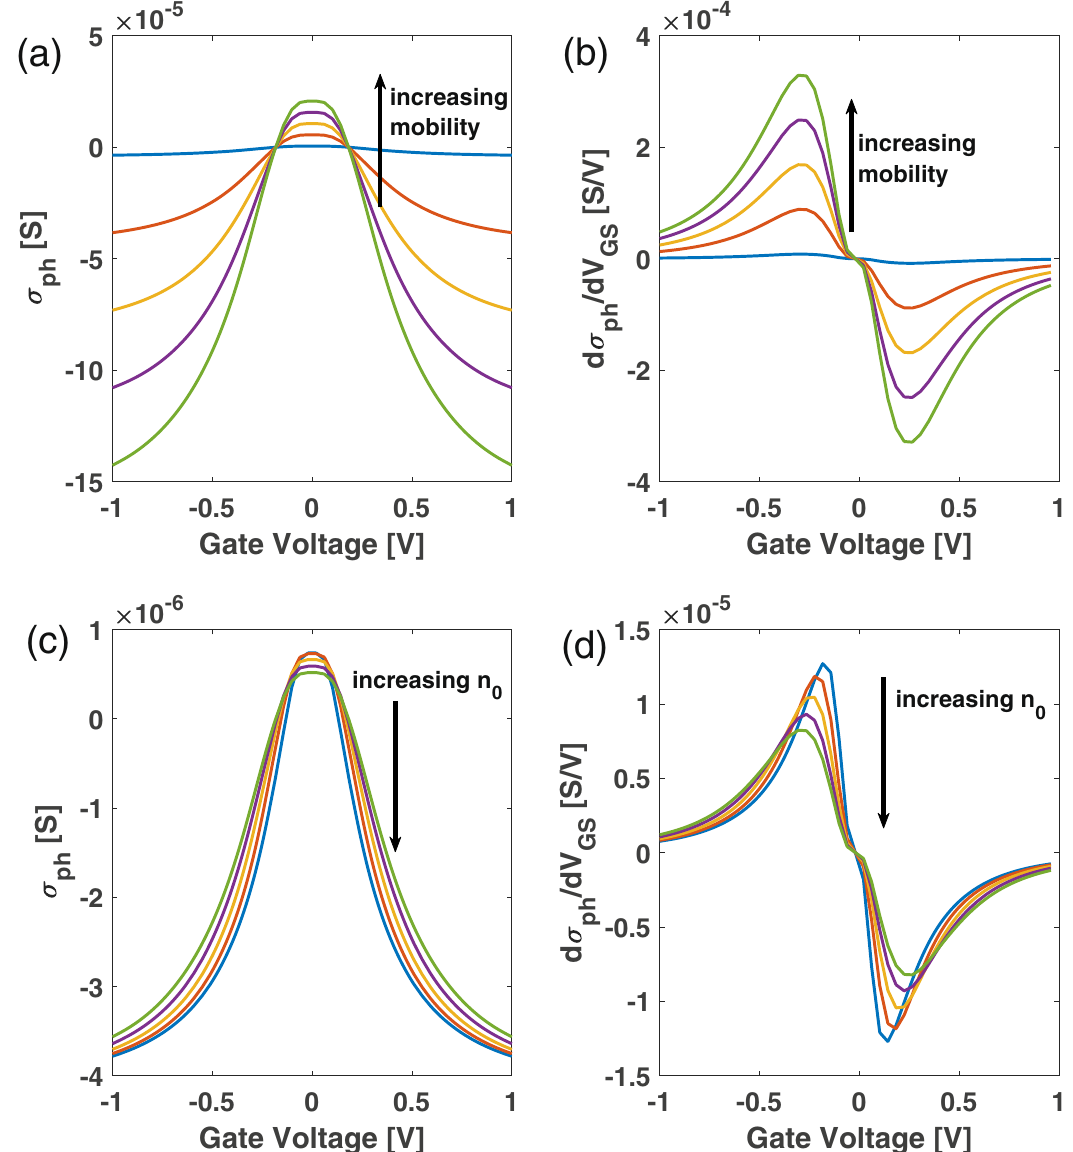
Fig. 8 Optoelectronic-mixing performance. a Calculated photoconductivity and b photoconductivity derivative for μ fe varying from 3800 to 100,000 cm 2 V − 1 s − 1 . c Calculated photoconductivity and d photoconductivity derivative for n 0 varying from 10 11 to 4.5 . 10 11 cm − 2